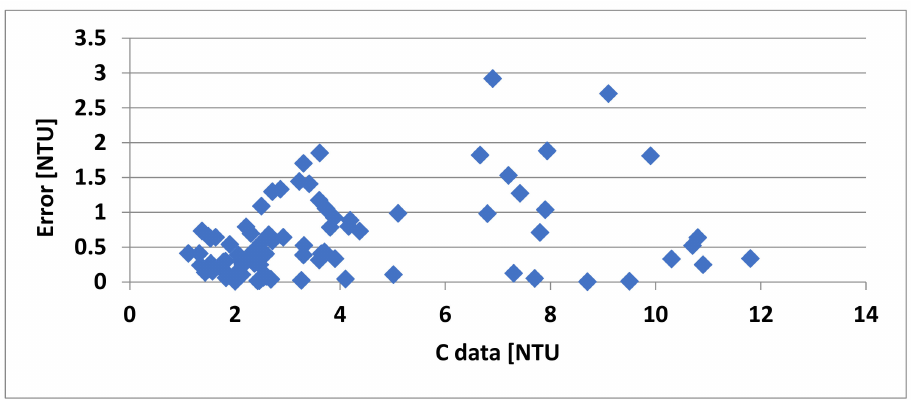
Figure 25. Model errors for turbidity versus measurement data.